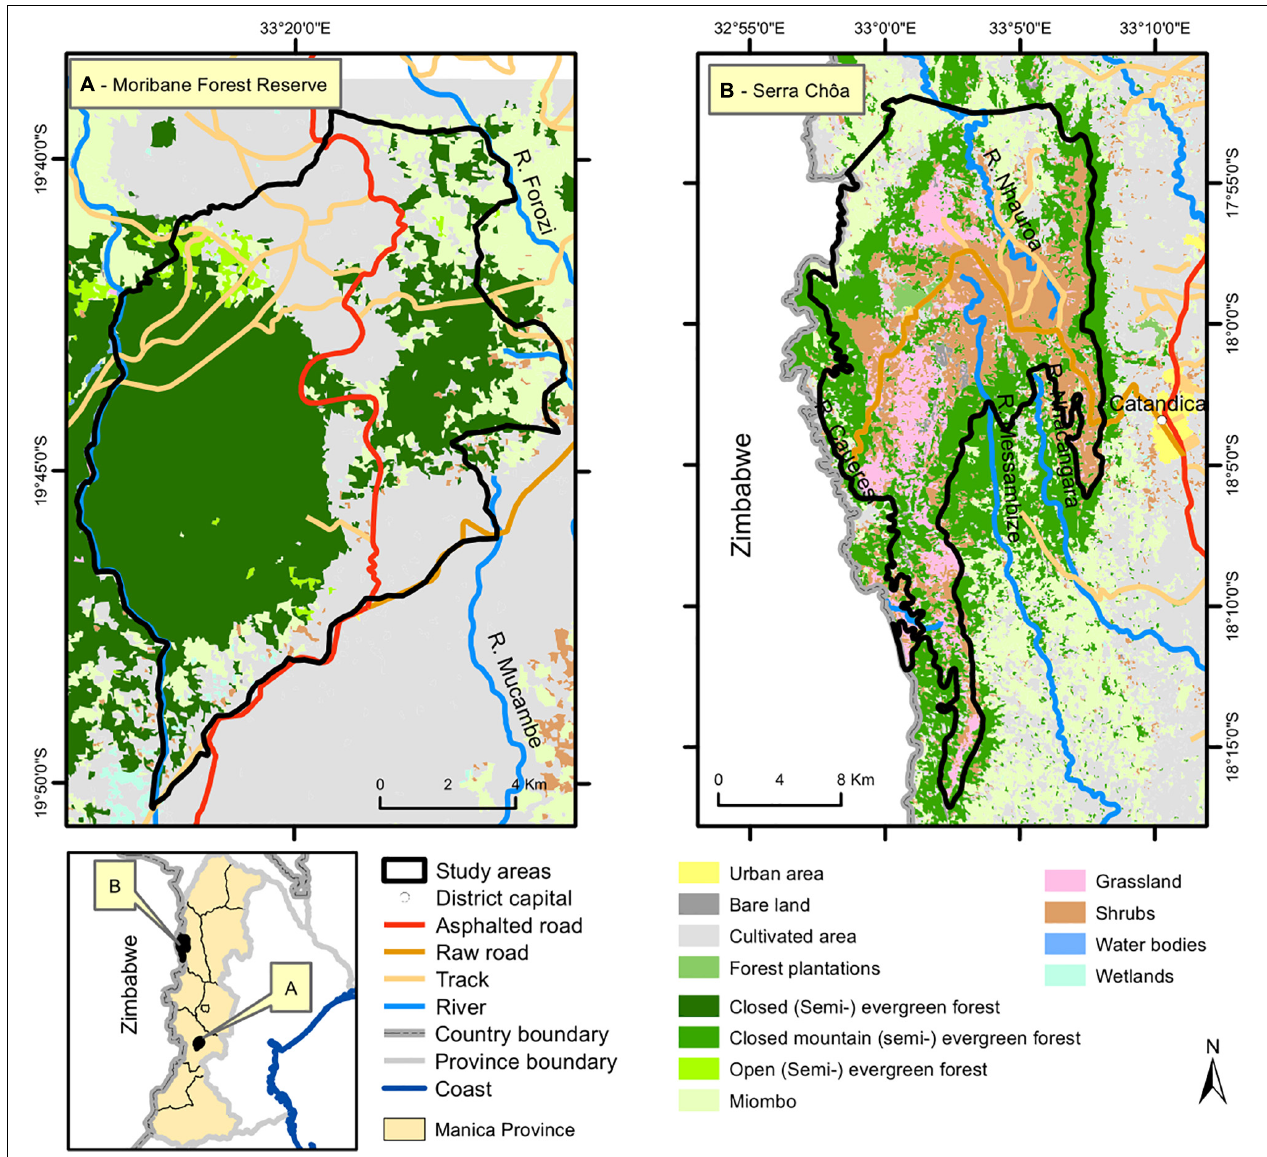
FIGURE 1 | Study area (MFR and SCH) location and land use and cover (based on FNDS, 2019, available at: https://www.fnds.gov.mz/mrv/index.php/ documentos/relatorios/39-relatorio-de-mapa-de-cobertura-florestal-2016-versao-2/file).